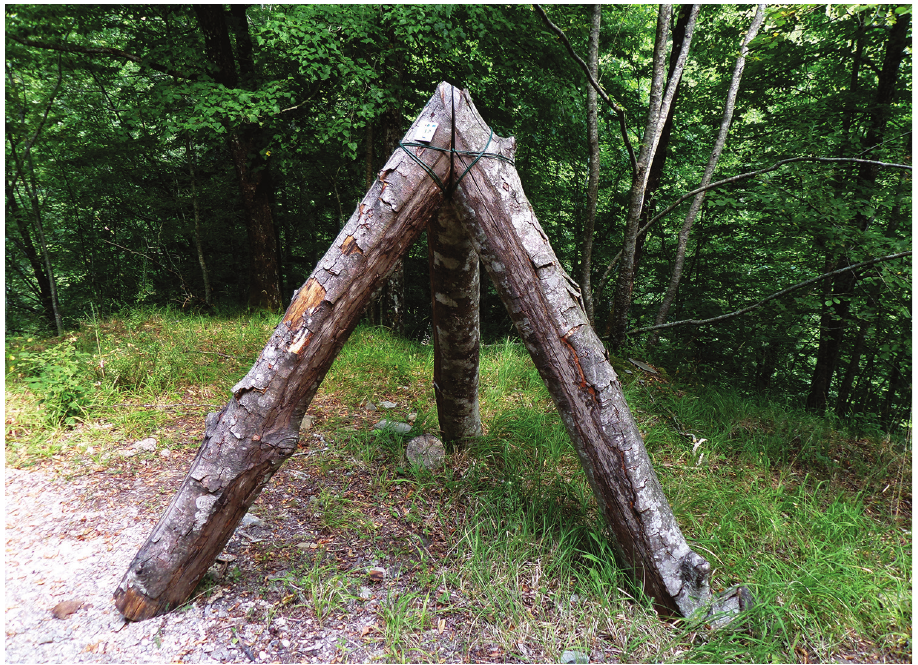
Figure 4. A tripod made with beech woods, used as sampling unit for the monitoring of R. alpina in the Foreste Casentinesi during 2014–2016. Table 1. Main characteristics of the survey schemes applied for the monitoring of R. alpina .